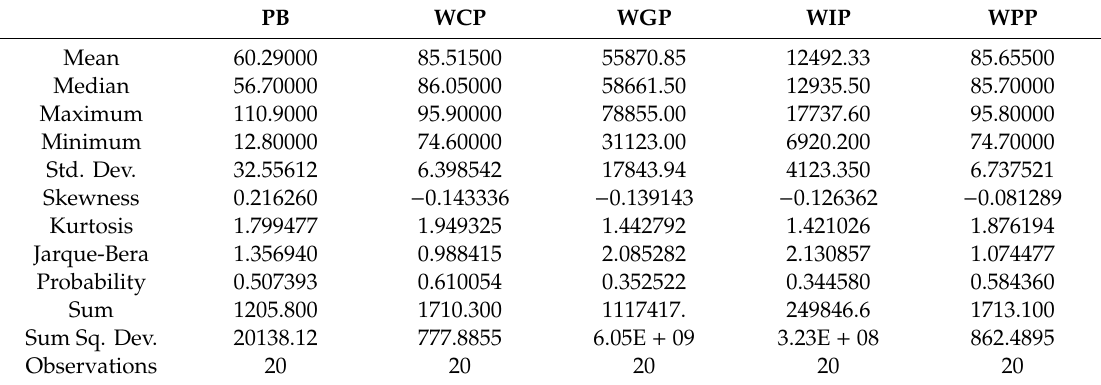
Table A2. W. Descriptive